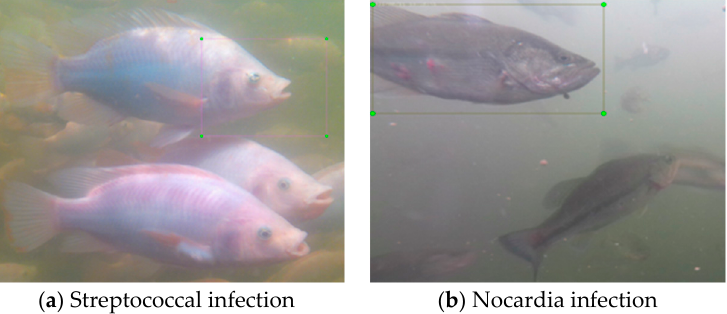
Figure 3. Typical images of fish infection. Note: The infected fish in the figure are inside the Ground truth box, and normal fish are found outside the Ground truth box. To further clarify the trend of fish infection with culture time, 25 images of red tilapia and micropterus salmoides were selected for tagging each day, and a total of 6000 images were tagged, with 50% of each of the two species. The labelled images were divided into a train set and a validation set according to 80% and 20%, and another 1000 images were selected from the images taken as a test set, with 50% of each species. The number of disease and illness levels for each fish species in the captive barrel was counted, as shown in Table